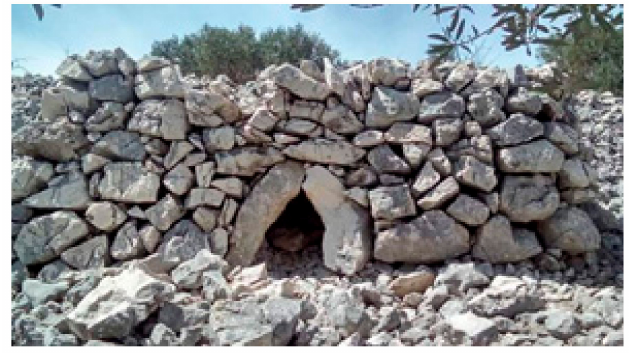
Figure 26. A stone pile with a dry stone wall on top (Goran Andlar, 2016).